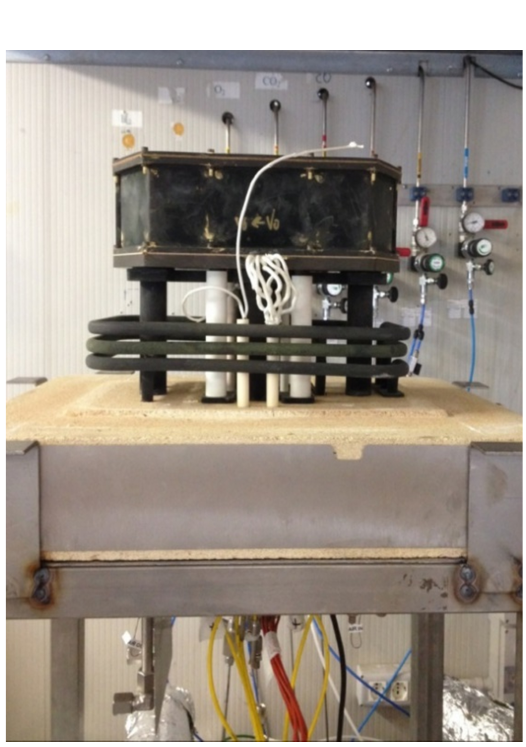
Figure 2 . Photo of the short stack set-up . Figure 2. Photo of the short stack set-up.